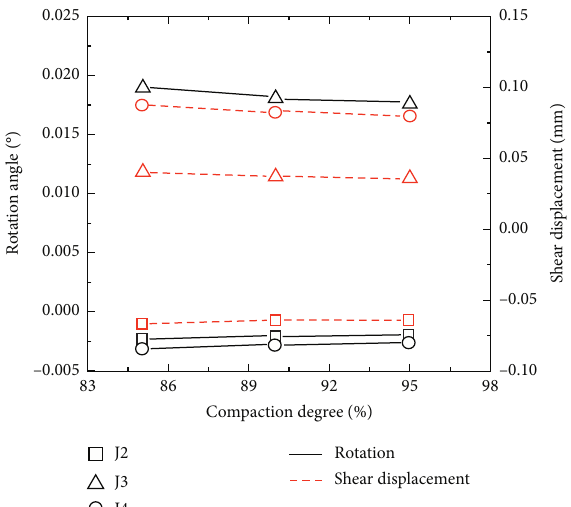
Rotation displacementJ2 Shear J3